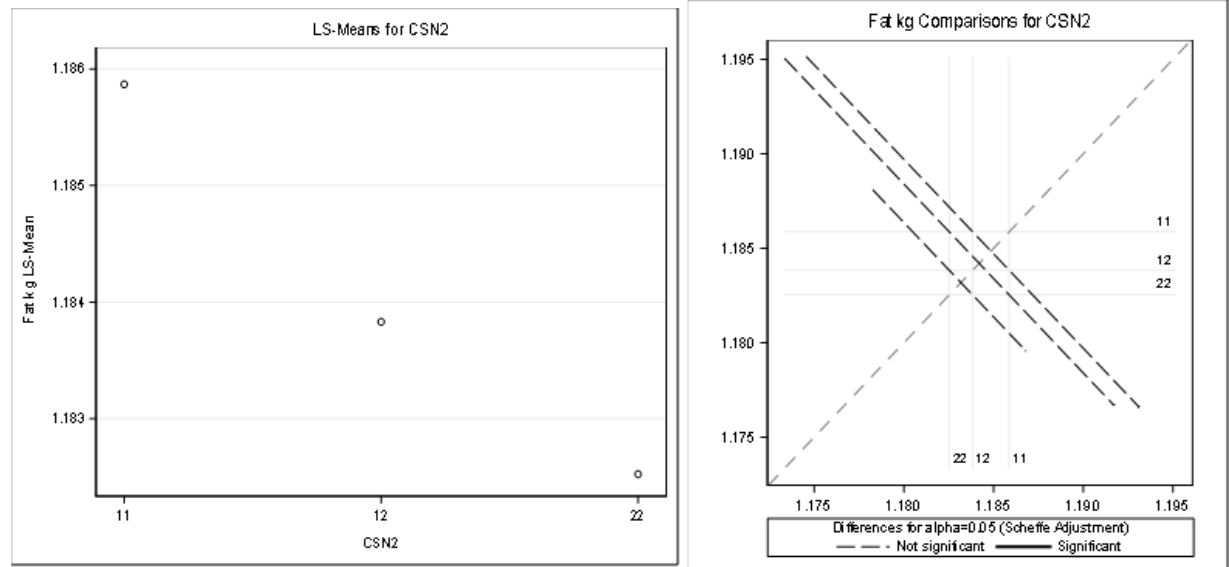
Figure 4. Least squares means and multiple comparisons for milk kg.